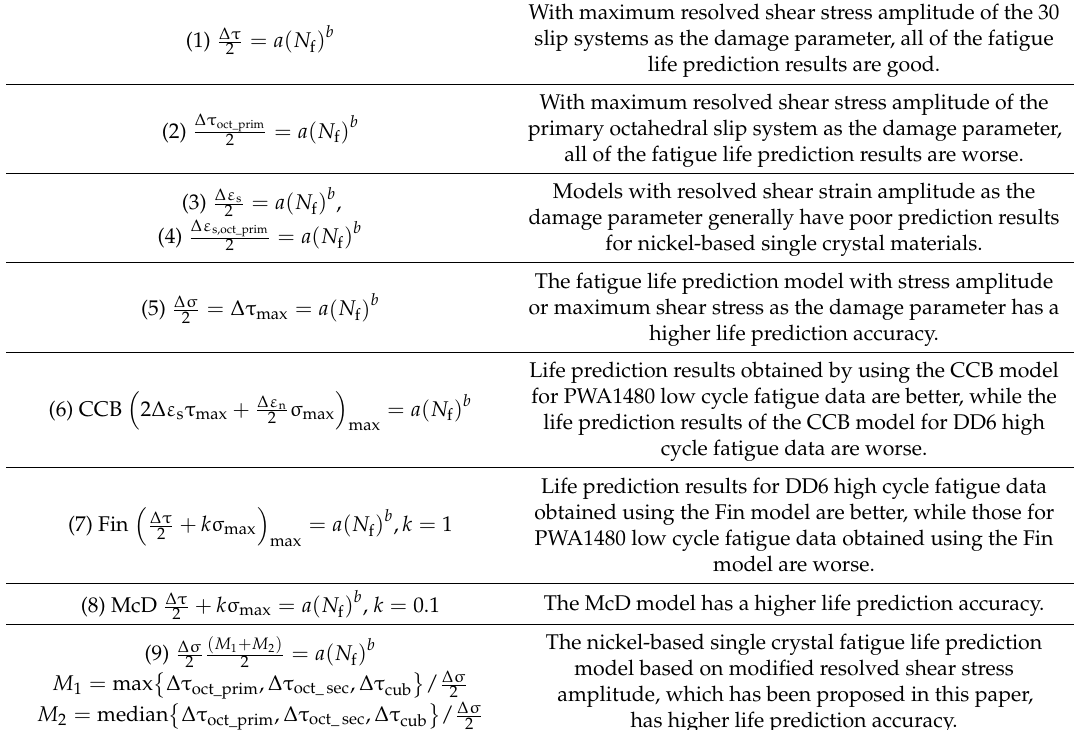
Table 5. Nickel-based single crystal fatigue life prediction